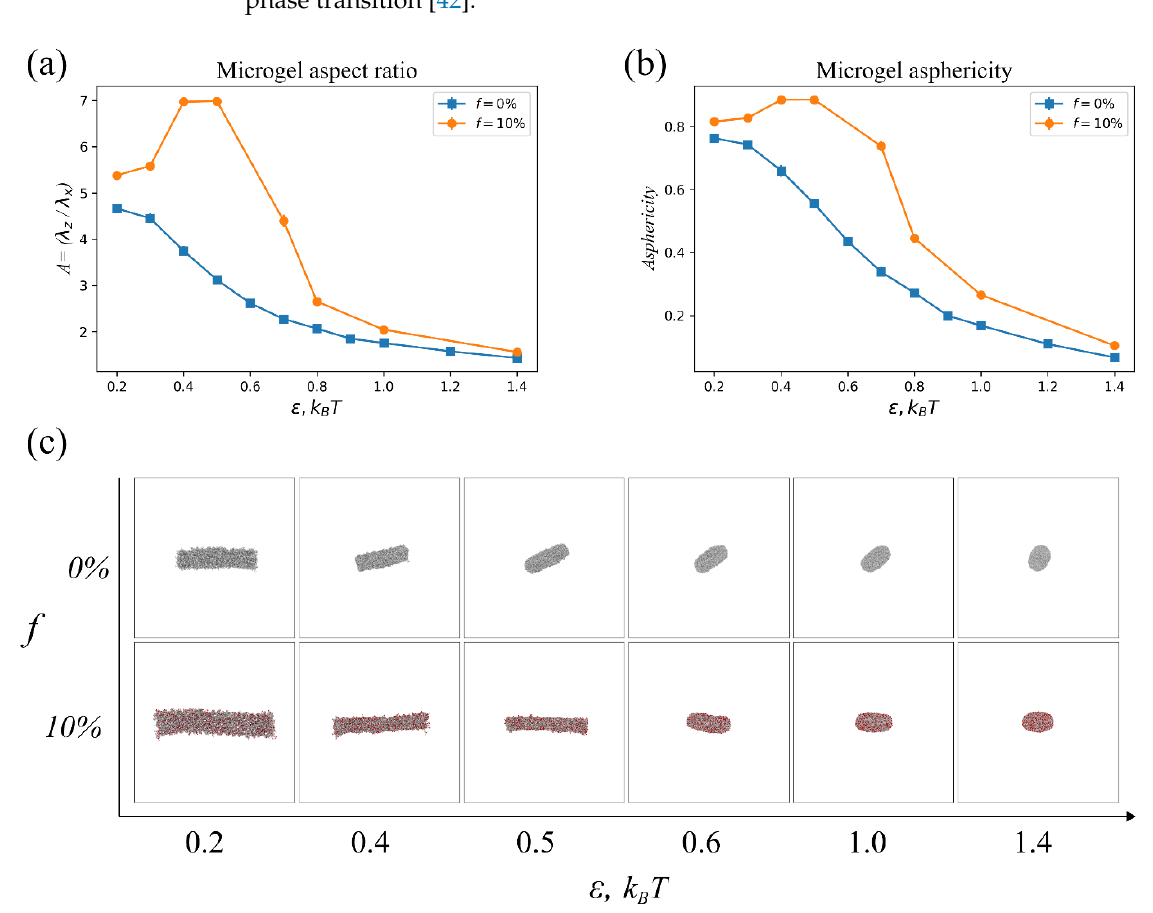
Figure 4. ( a ) Aspect ratio calculated from eigenvalues of gyration tensor λ z / λ x [41]. ( b ) Asphericity parameter and ( c ) snapshots of equivalent neutral ( f = 0%) and charged ( f = 10%) microgels vs. interaction parameter ε . The molecular weight and subchain length of the microgel are N = 50,000 and M = 10, respectively. The initial aspect ratio of the microgels is A = 4.